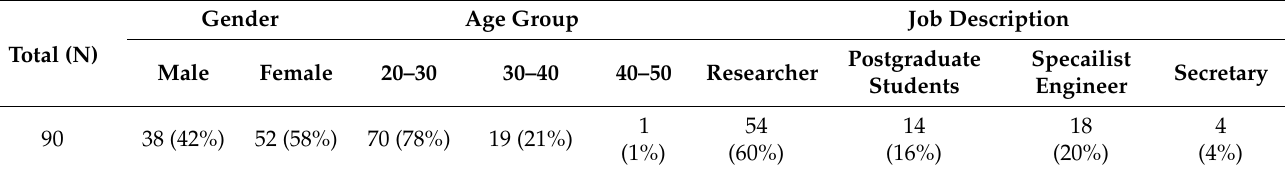
Table 3. POE occupants’ demographic information.